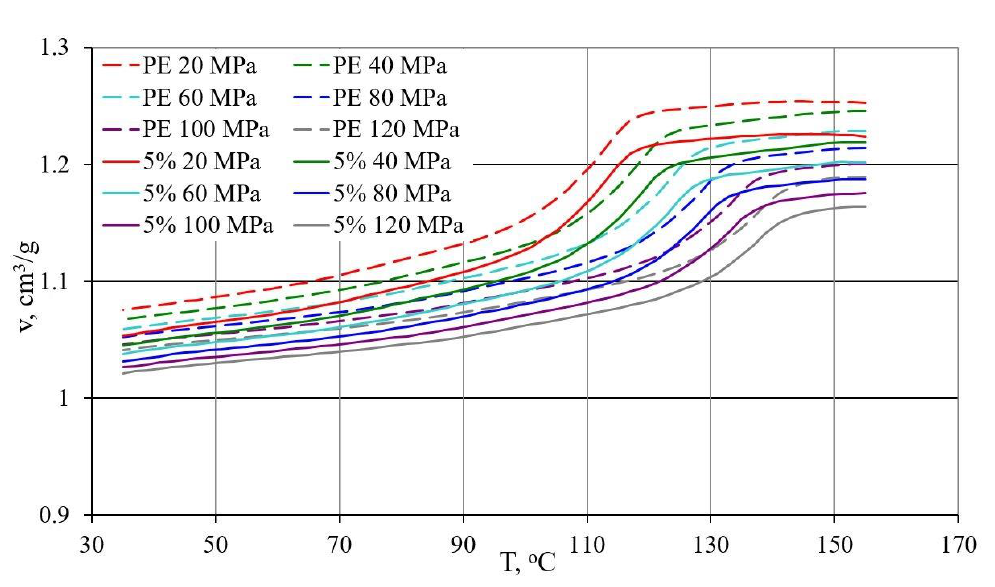
Figure 14. Dependence of specific volume v on temperature T for unfilled PE (dashed lines) and PE with 5% fraction content <0.4 mm bran (continuous lines), at different pressure values.